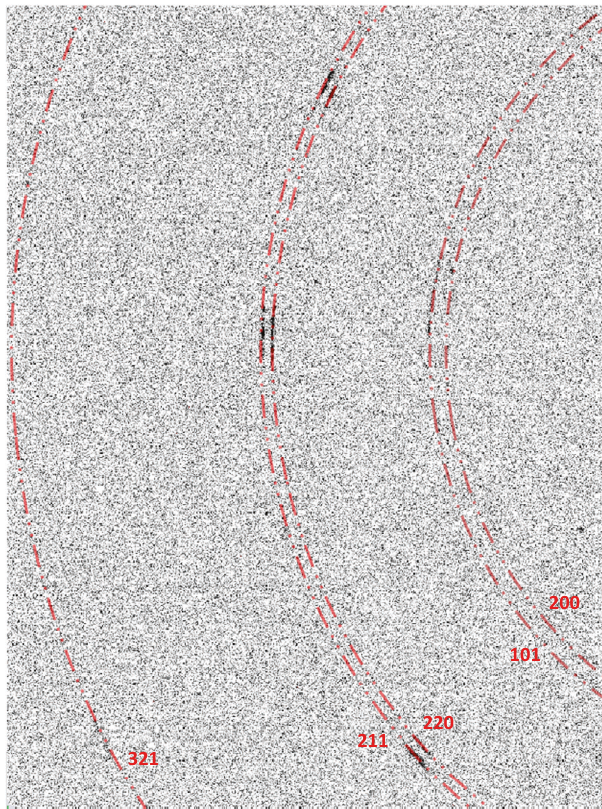
Fig. 2 Oscillation diffraction pattern from Si-II obtained with monochromatic beam in 1° angular range. Red circles denote predicted diffraction lines of